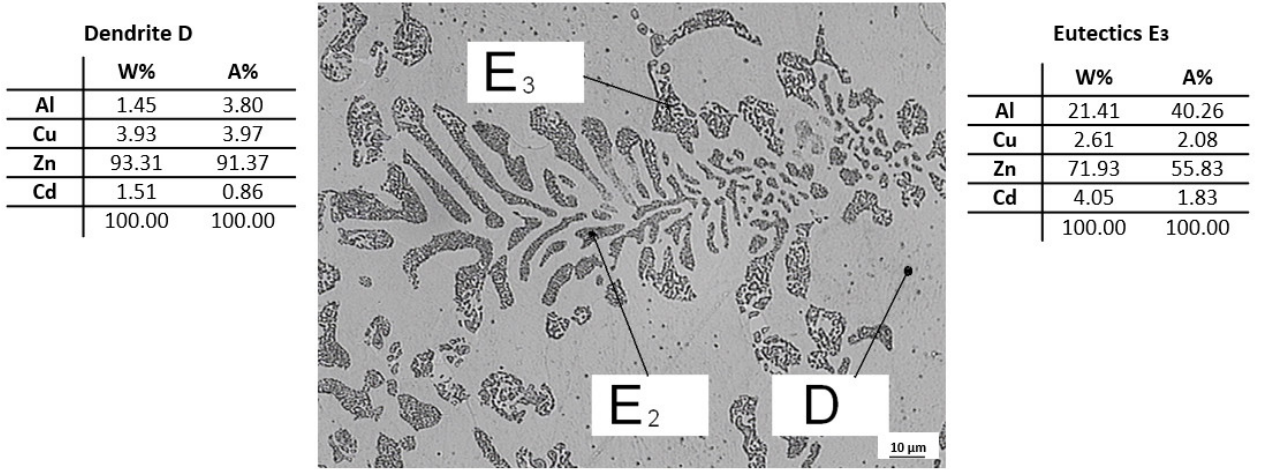
Figure 14. Microstructure of ZnAl4Cu3 alloy with addition 3 wt.% Cd (C9) with quantitative analysis of eutectic E3 and dendrite D.